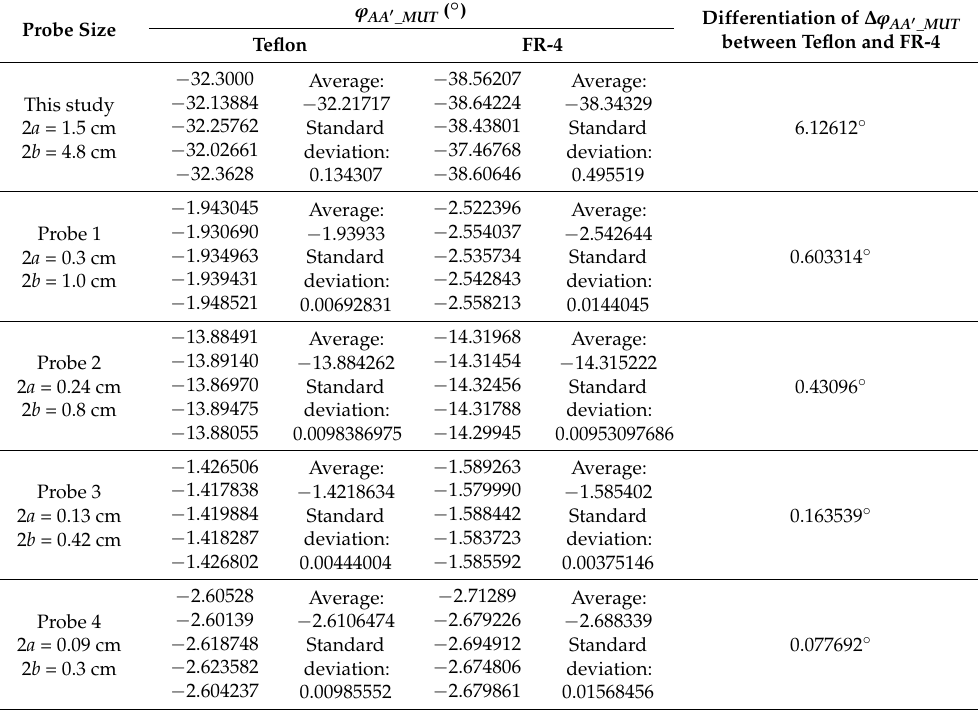
Table 3. Measured ϕ AA (cid:48) _MUT for Teflon and FR-4 sheets with h = 1 mm backed by metal plate at 50